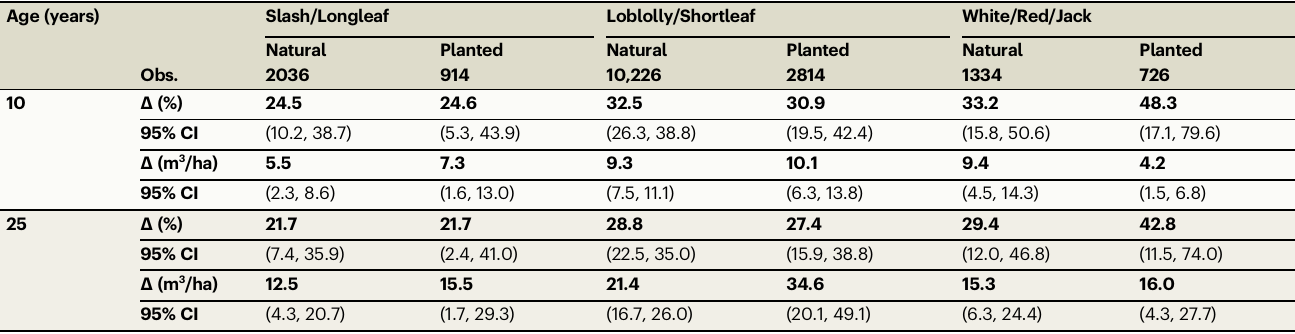
Table 2 | Change in predicted volume from 1970 to 2015 due to carbon fertilization on naturally regenerated and planted pine stands at ages 10 and 25 using observations aged 1 – 50 Age (years) Slash/Longleaf Loblolly/Shortleaf